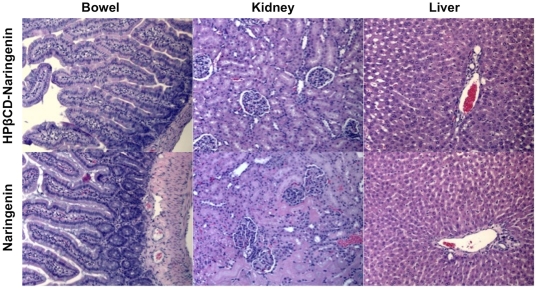
Male Sprague-Dawley rats were fed 20 mg/kg body weight naringenin either alone, or as a HPβCD-naringenin complex.Animals were sacrificed 10 hrs post-treatment and tissue samples were collected and preserved. Representative images of H&E histological preparations from bowel, kidney, and liver are presented. Tissues were evaluated by a blinded pathologist and were judged to be normal with no signs of inflammation or necrosis.